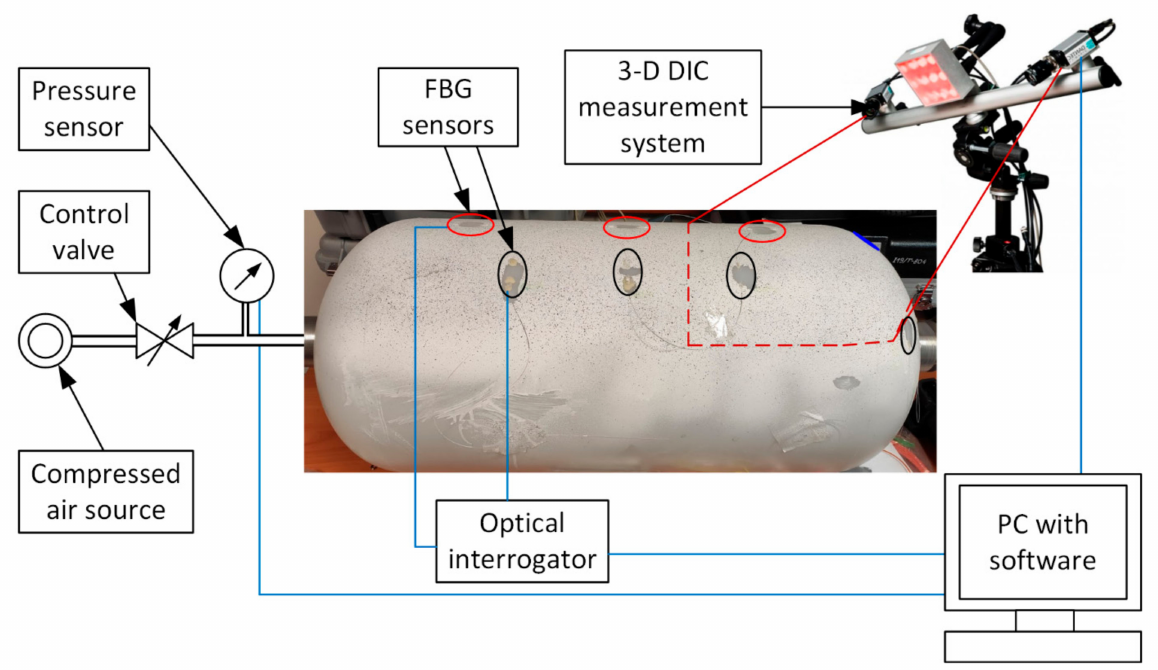
Figure 8. Experimental setup for liner testing using the DIC method and FBG sensors. Dashed line shows the part of the liner inspected using the DIC